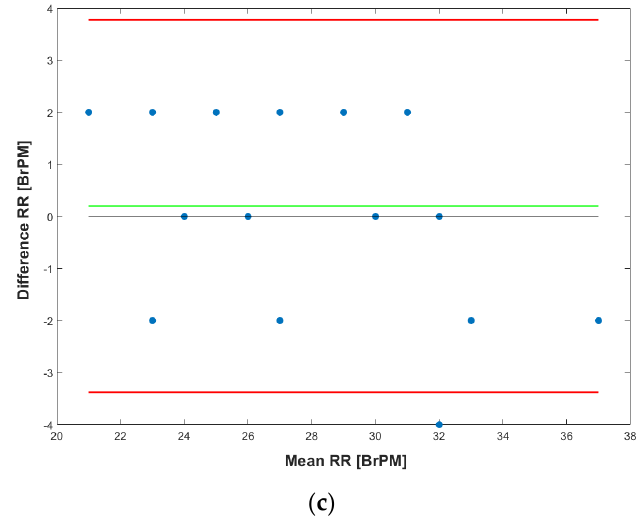
Figure 11. Bland–Altman graphs of the measurements obtained by the developed chest band and those obtained by breath counting when the user is: seated ( a ), standing ( b ), and walking ( c ).